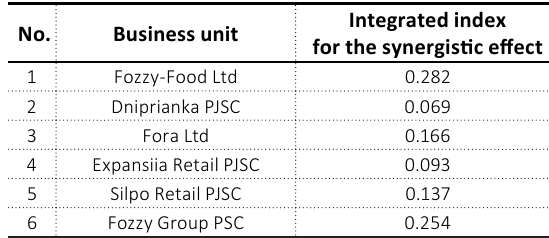
Table 3. The results of integrated indices calculation in the framework of estimate parameters assessment for the